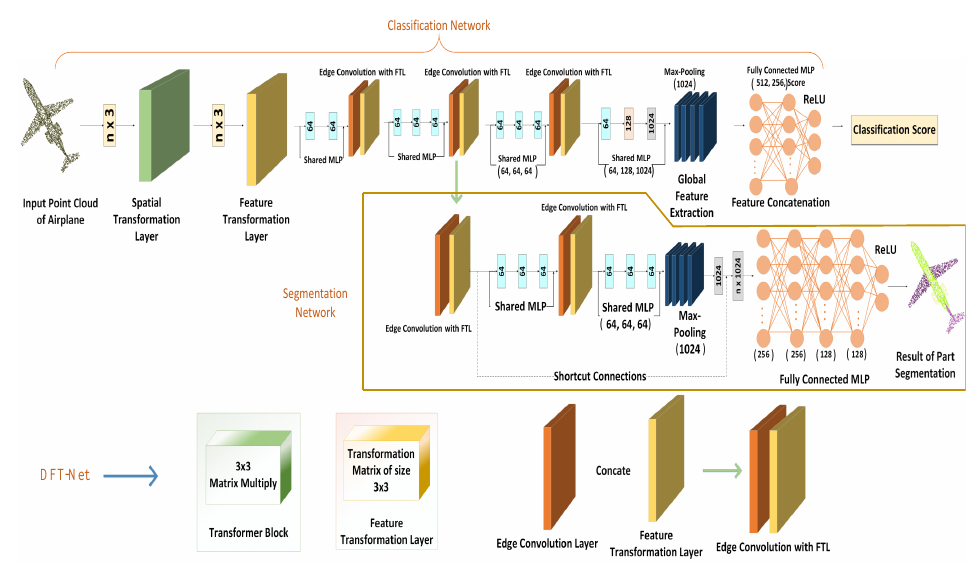
Figure 1. The Proposed Model